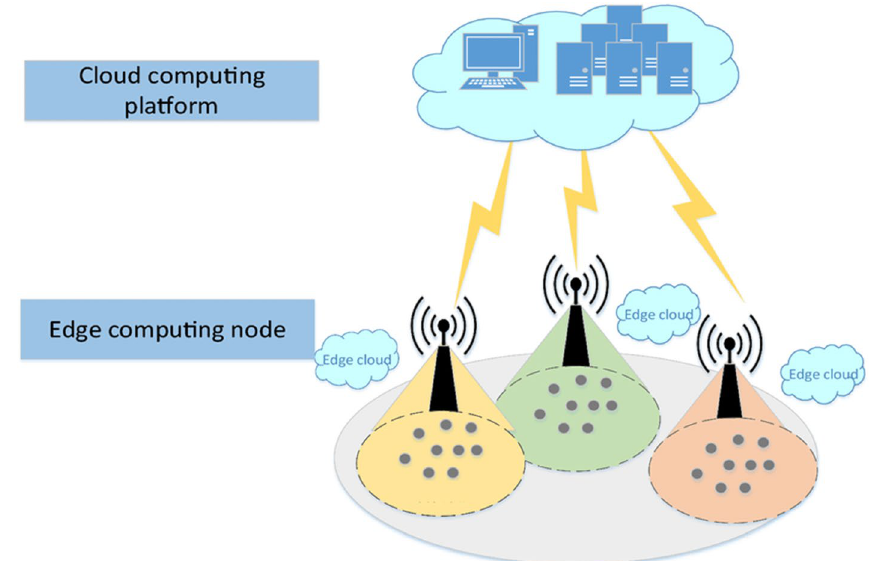
Fig. 7 The DU-Net network implementation over the edge cloud platform